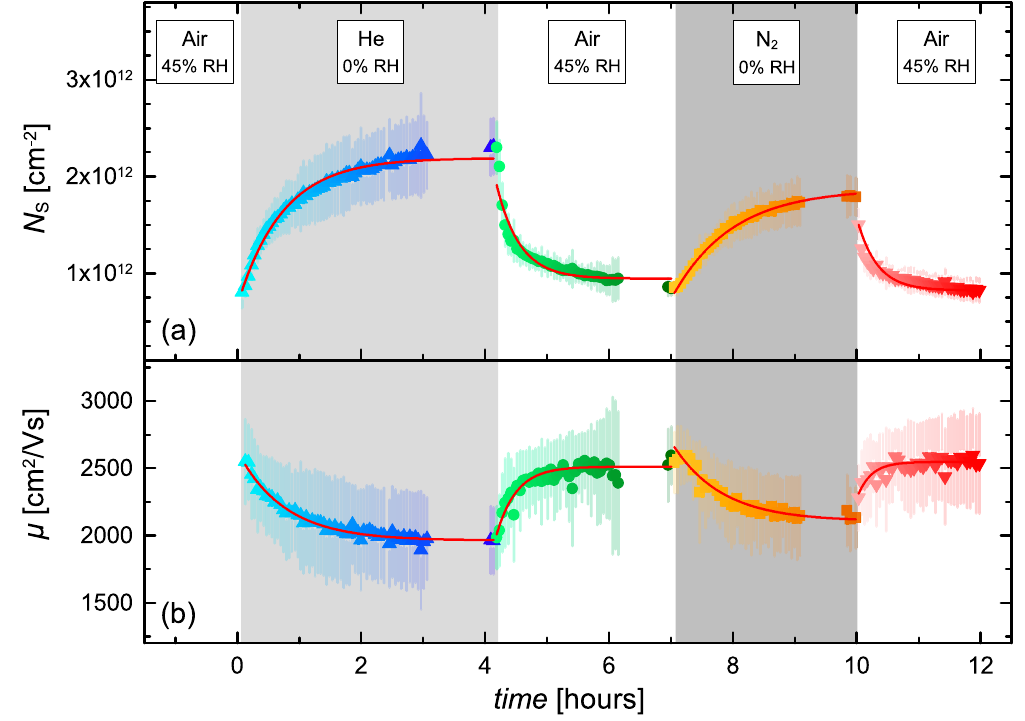
Figure 2. Best-match model results for sheet carrier density N s and mobility μ as a function of time. The shaded regions correspond to exposure to different types of gas at various relative humidities (RH). The flow rate of 0.5 liters/minute at normal pressure is constant for all exposure phases. Error bars for the best-match model parameters are shown here for each data point as vertical lines. Solid lines depict single-process exponential decay functions, for which rate constants and equilibrium parameters are given in the